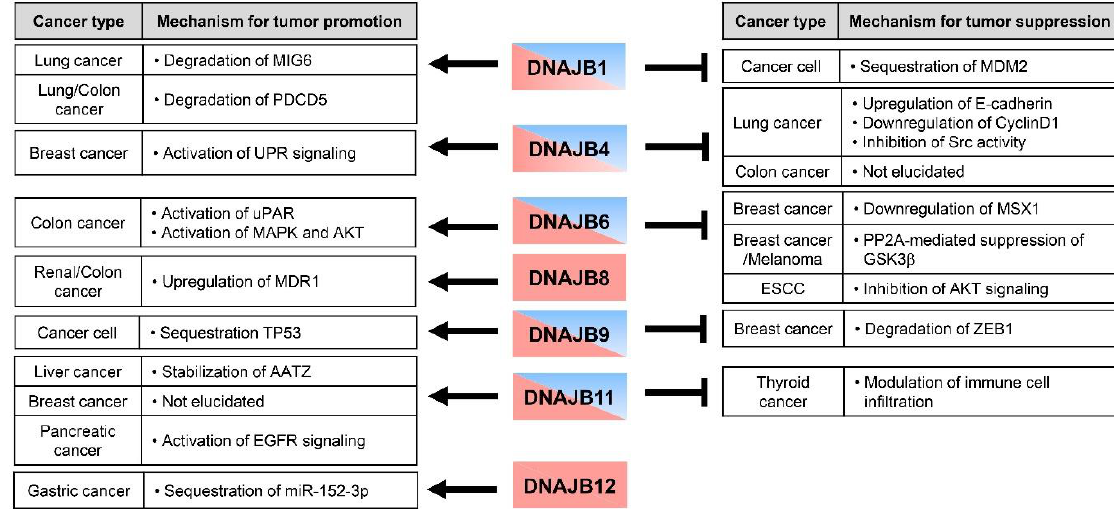
Figure 2. Multi-faceted roles of DNAJB protein in cancer pathology. DNAJB proteins act both as tumor promoter (red color) or suppressor (blue color) depending on tissue type and context-dependent manner. DNAJB8 and JB12 proteins promote tumor growth and metastasis in several cancers. Interestingly, other DNAJB proteins have divergent roles in cancer development and metastasis as promoter or inhibitor.